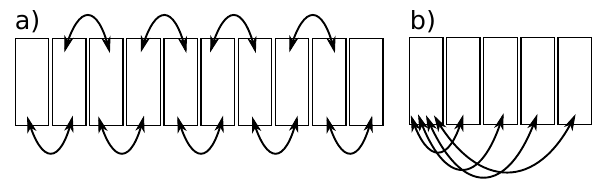
Figure 2. Schematic showing example channel combinations for high radial resolution δ T e / T e profiles (a) and correlation length measurements (b). Reproduced from [7].